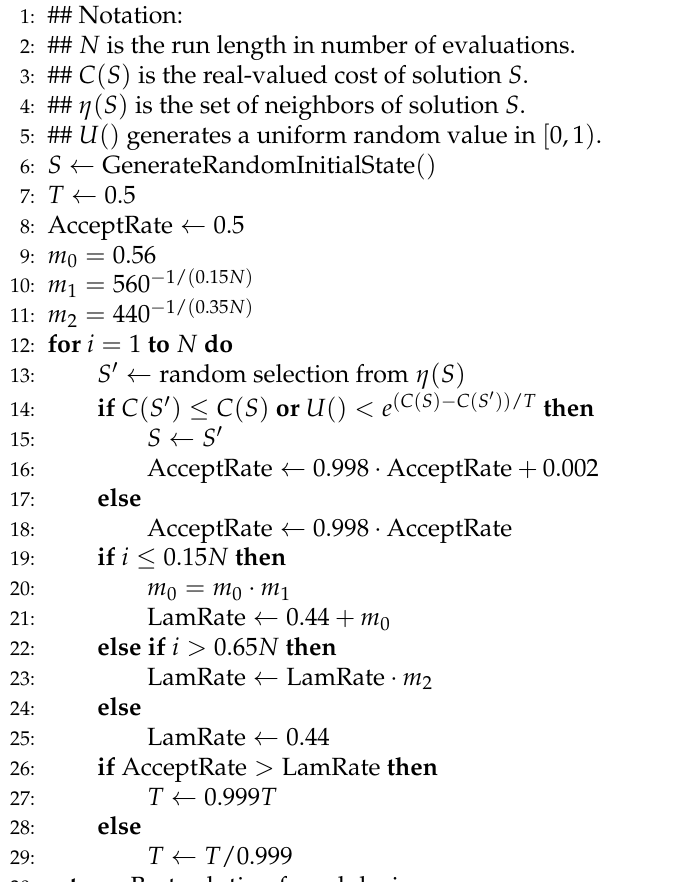
Algorithm 2 Optimized Modified Lam